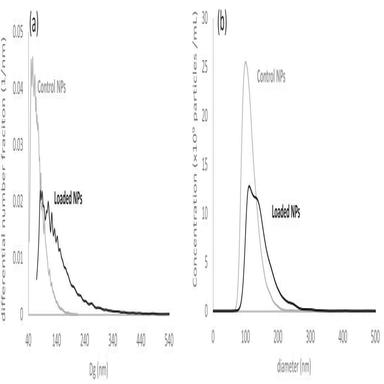
Number size distribution of loaded (in black) and control (in grey) formulations obtained by (a) AF4-UV-MALS and (b) NTA analysis.